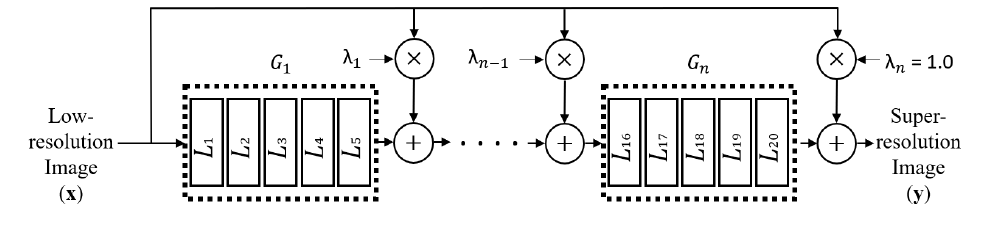
Figure 2. Proposed network structure with skip connections for each layer group ( l = 20, k = 5, n =